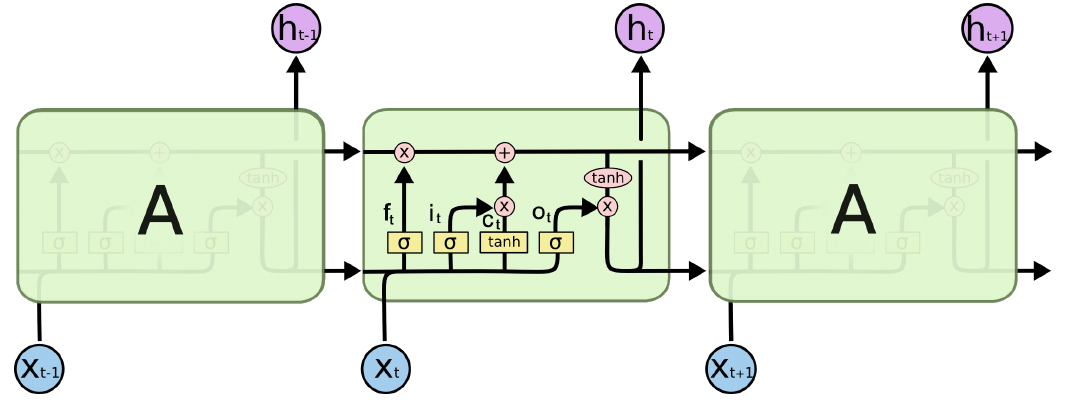
Figure 1. The repeating module in an long short-term memory networks cell